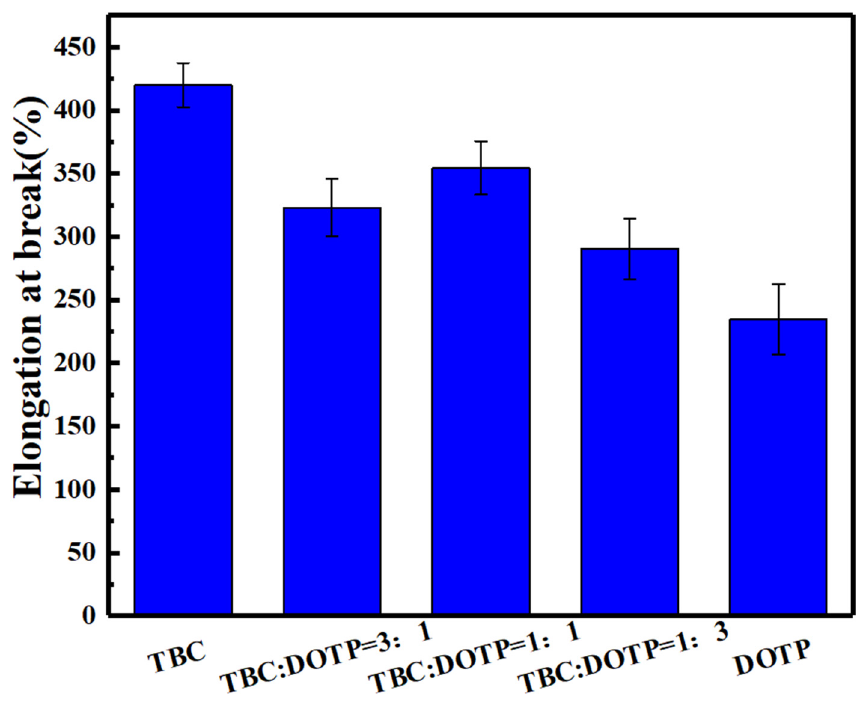
Figure 12. The elongation at break of PVC with Zn(Arg) 2 plasticized by TBC and DOTP in different proportions.